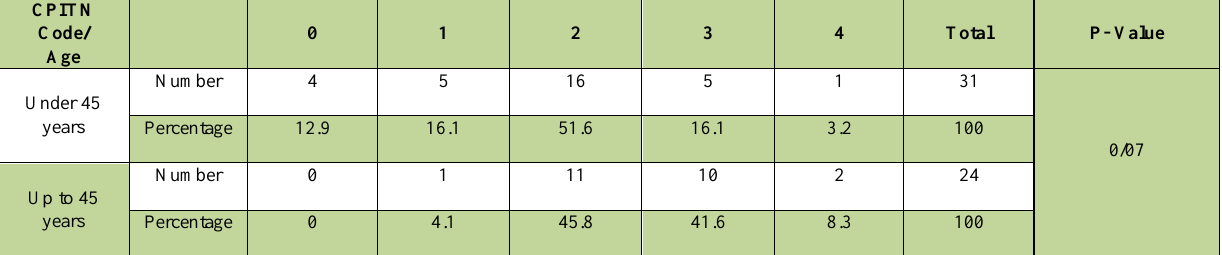
Table 4. Frequency distribution of CPITN index in subjects studied by